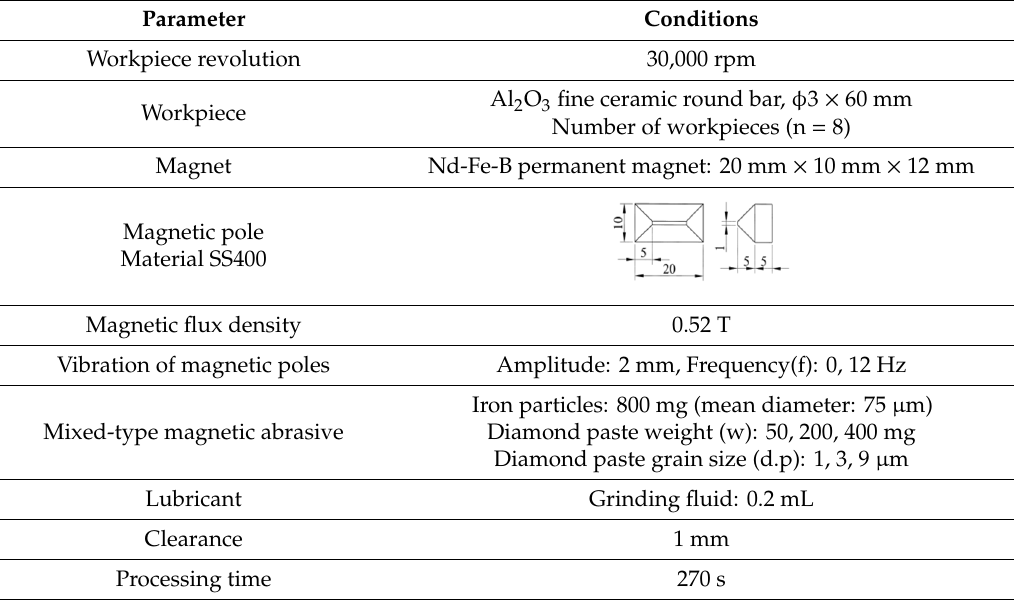
Table 2. Experimental conditions.